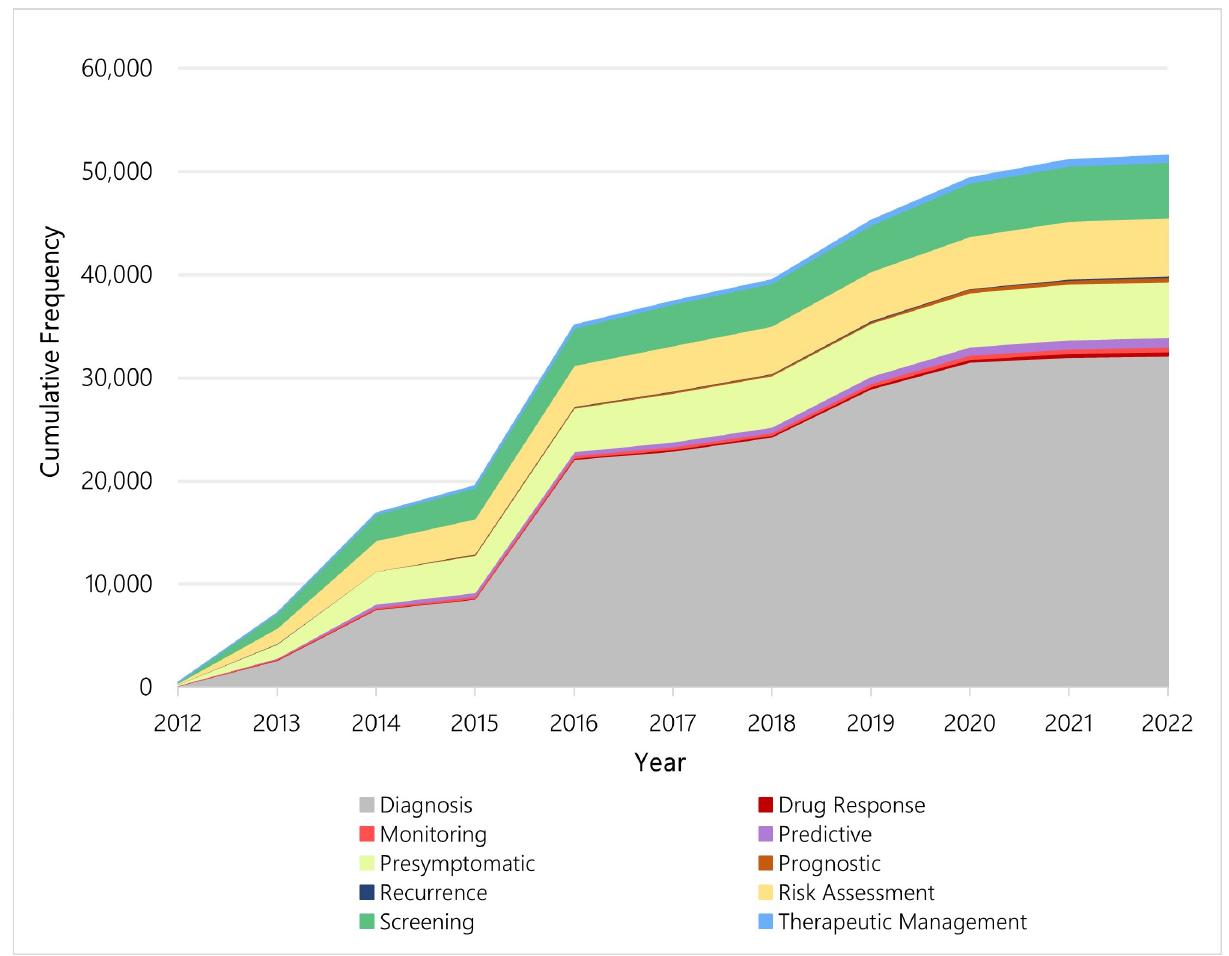
Figure 5. Cumulative frequency of new genetic tests per year by test purpose category, US.